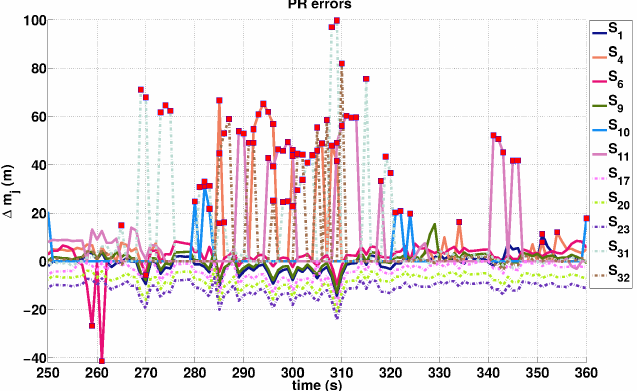
Figure 4. ˜ ∆ m j estimations on PR measurements acquired by the different satellites (numbered between 1 and 32). Red markers point out PR outliers detected by NFA.